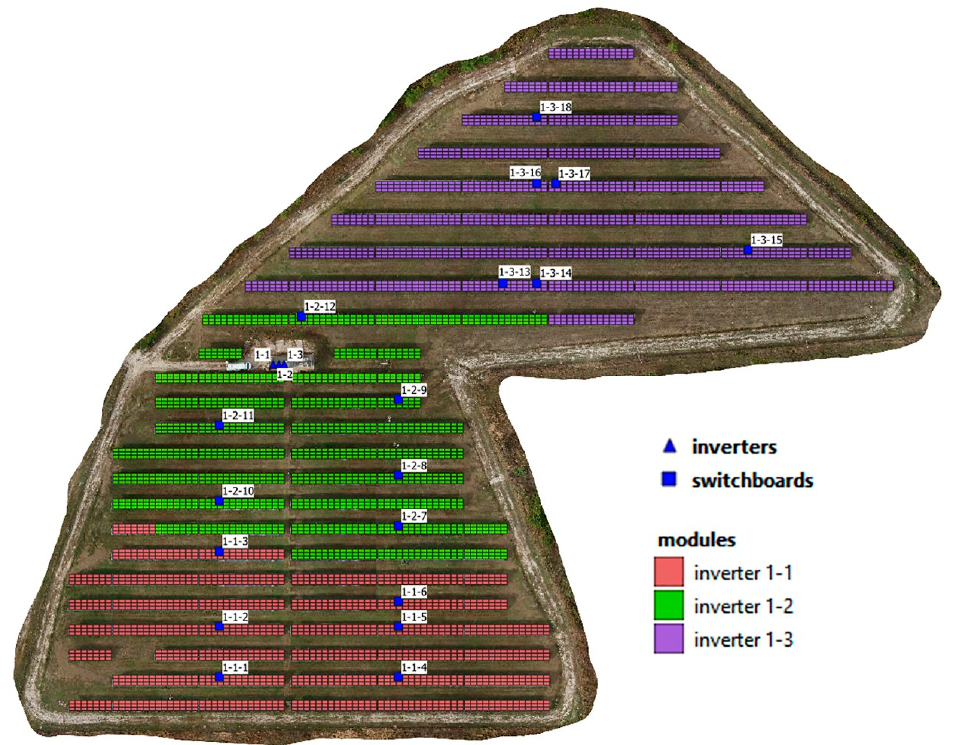
Figure 15. The customized map of a PV system that illustrates the positions of the inverters and switchboards and indicates which inverter the modules are connected to using different colors. (Plant B). For the PV inspection, the thermal images have been collected according to the maintenance